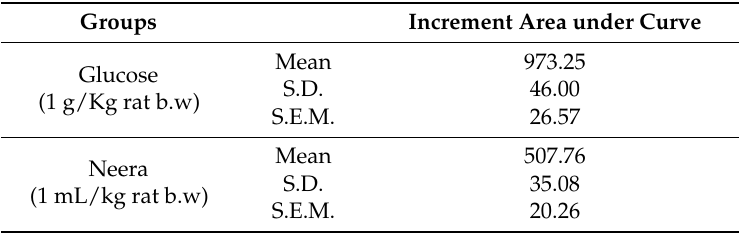
Table 6. The mean IAUC with standard deviation of Glucose (1 g/kg rat body weight) and Neera (1 mL/kg rat body weight)-treated Albino Wistar